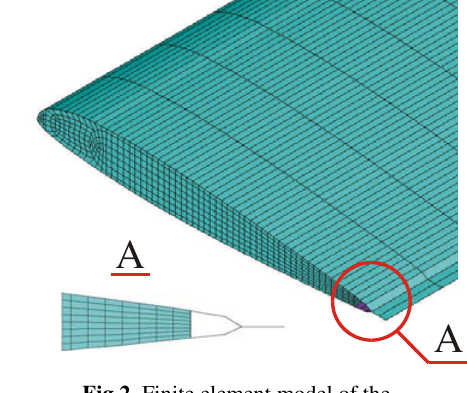
Fig 2. Finite element model of the helicopter rotor blade